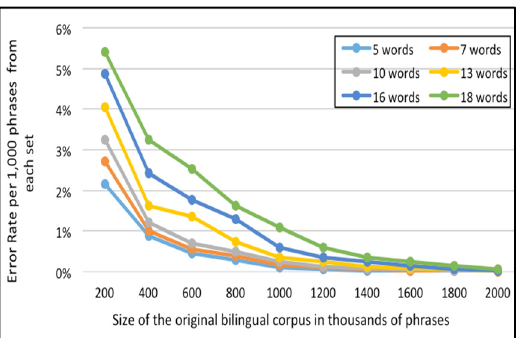
Figure 9. Error rate per 1000 phrases from each set (un-found phrases in the Corpus-Trie ), for the English-Arabic corpora.